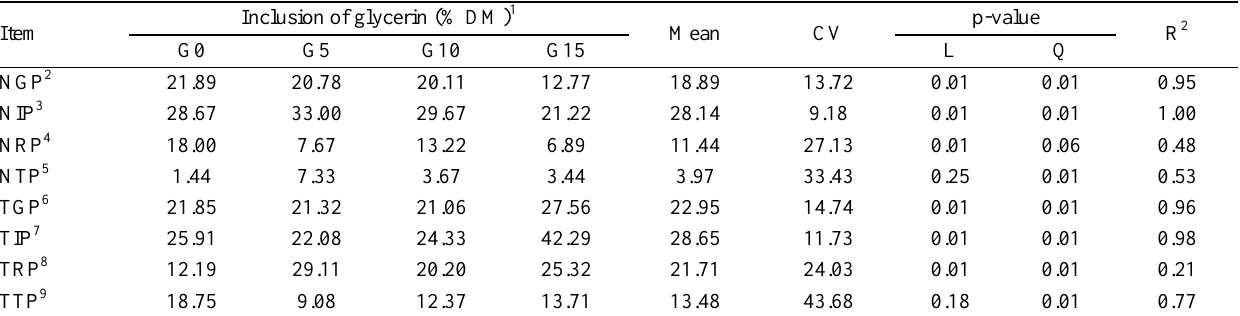
Table 6. Effect of addition of glycerin levels on the number of periods and duration (minutes) per period of the activities performed by supplemented heifers on a Brachiaria brizantha